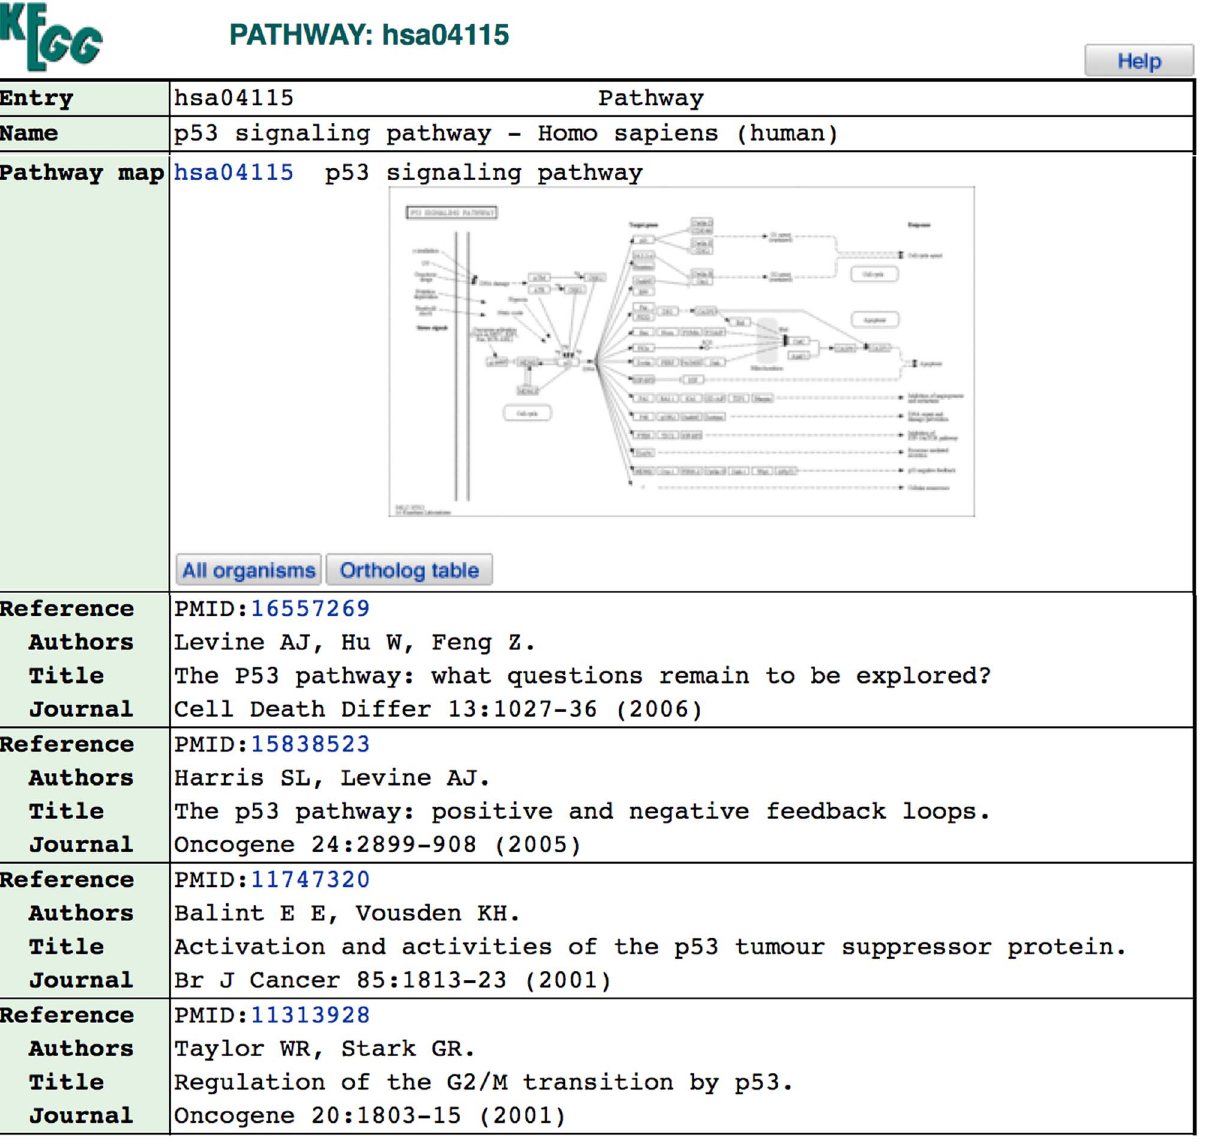
Figure 2. The KEGG p53 signaling pathway entry showing the pathway map and some reference citations. The PMIDs for each reference citation were used to identify MeSH terms with PubMed (see section Predication network generation ). http://www.genome.jp/kegg-bin/ show_pathway?hsa04115.